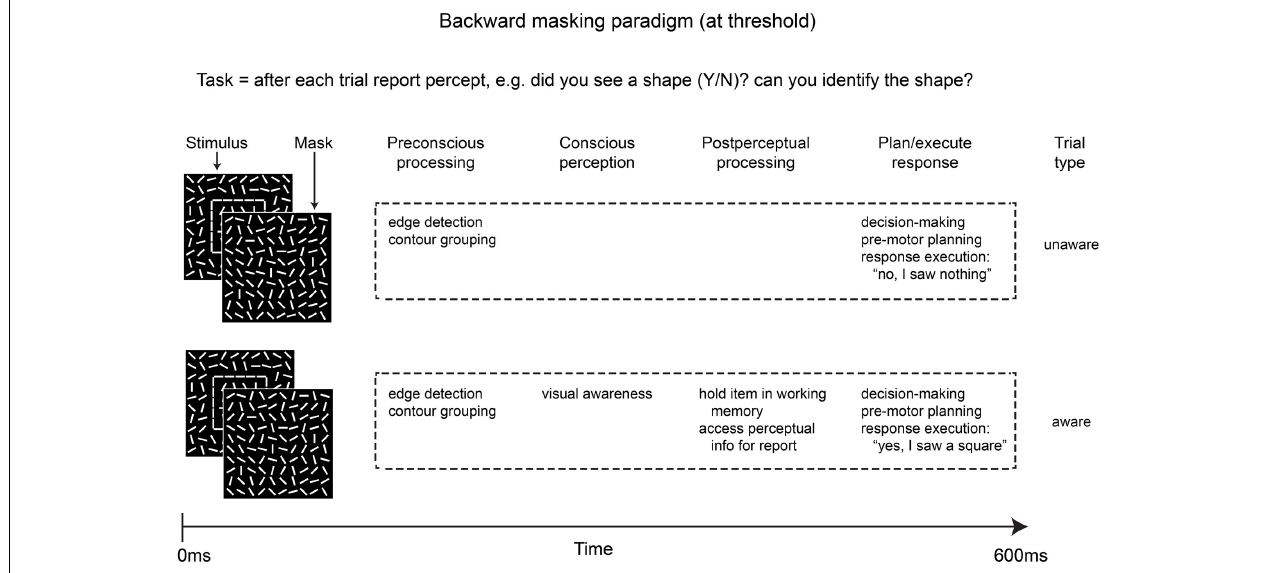
FIGURE 1 | Simplified schematic depicting some of the stages of processing involved in the two main trial types of a typical backward masking experiment in which the stimulus is masked at a constant SOA